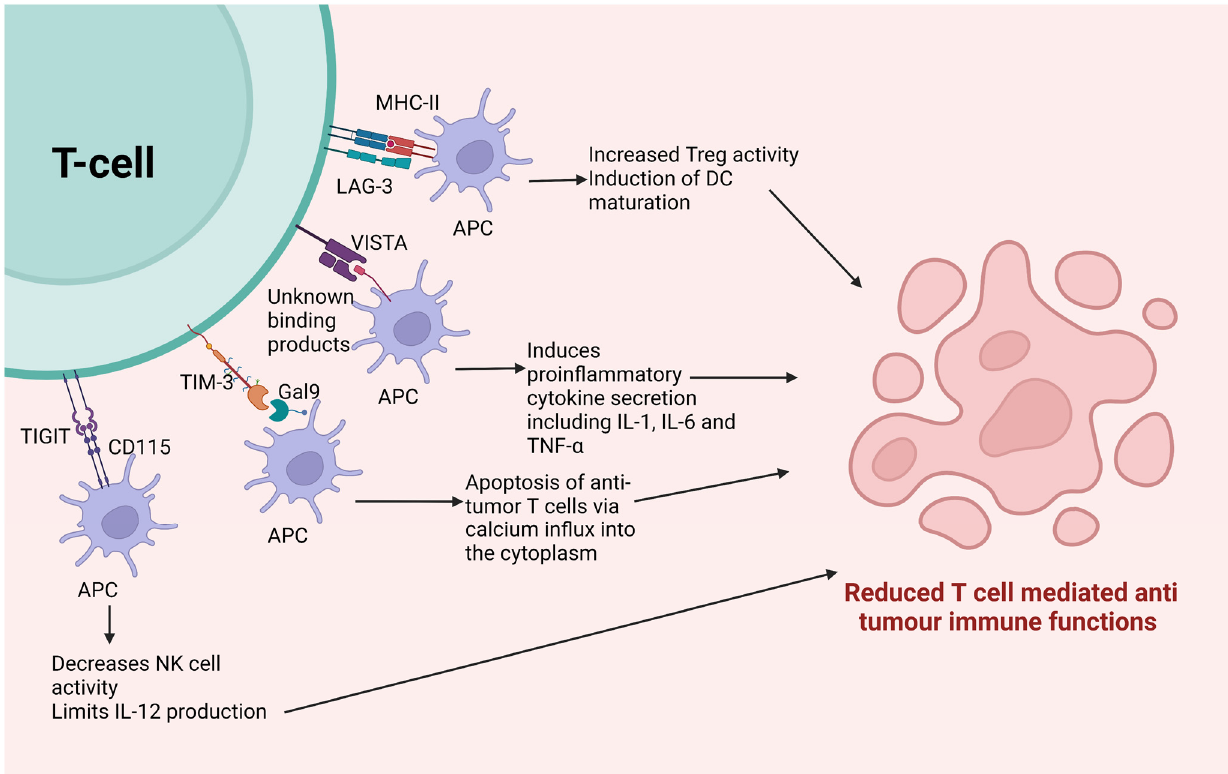
Figure 2. Immune checkpoints other than PD-1 and CTLA-4. Various immune checkpoints that are expressed on T cells following binding to their particular ligands lead to a series of immunosup- pressive reactions that ultimately suppress the anti-tumor immune activity of functional T cells.